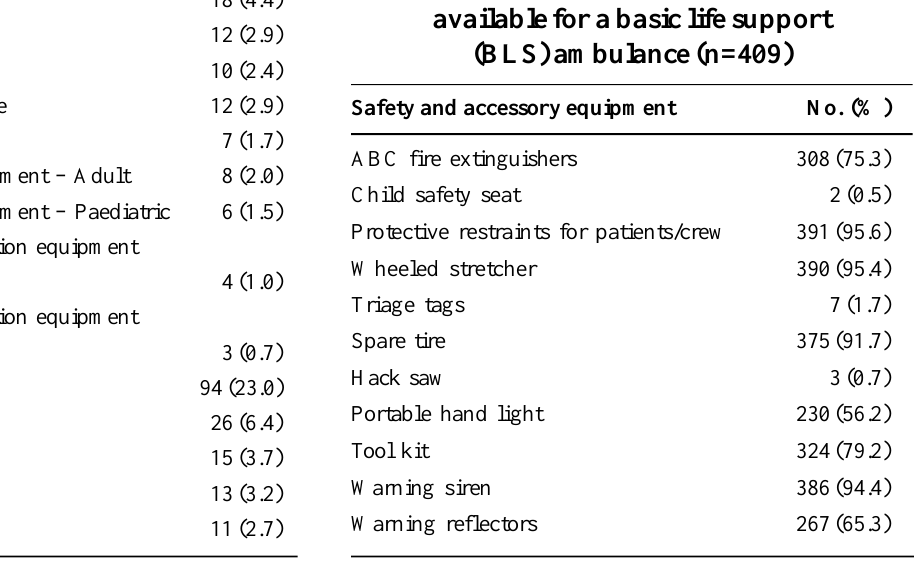
available for a basic life